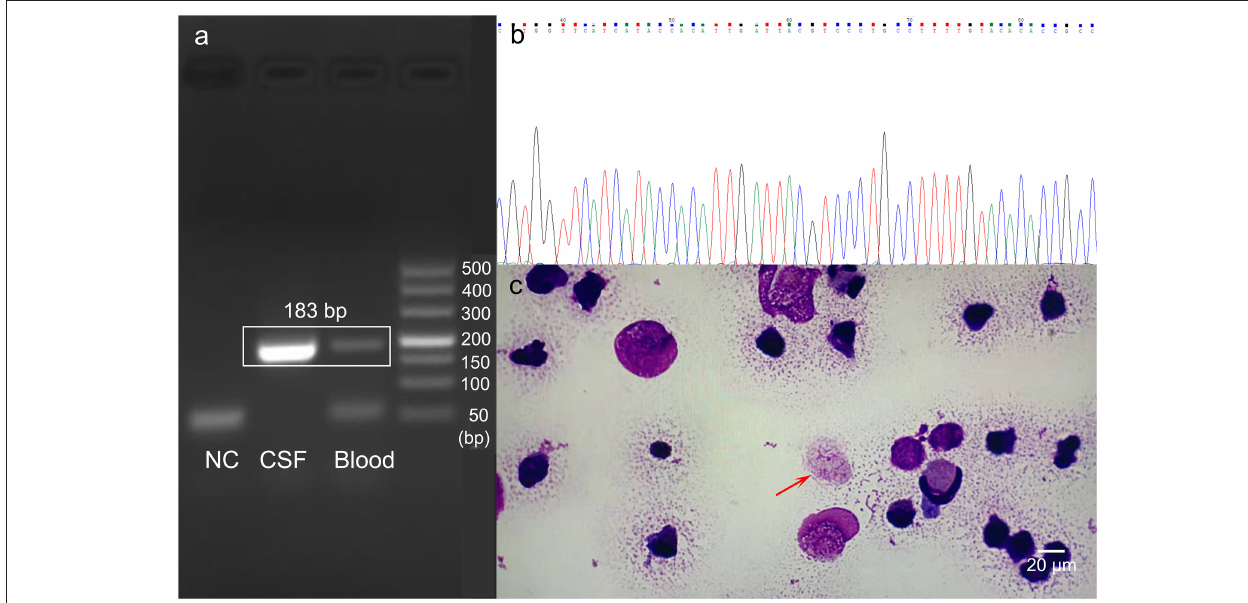
FIGURE 4 | N. fowleri infection verification by PCR and pathological examination of CSF slides. (a) PCR amplification bands exhibited by agarose gel electrophoresis. NC: negative control; marker: DL500. (b) The PCR result of N. fowleri in this patient detected by Sanger sequencing. (c) Image of N. fowleri on Wright-Giemsa-stained CSF slides (1,000x, oil immersion). The arrow indicates N. fowleri trophozoites (Scale bar: 20 µ